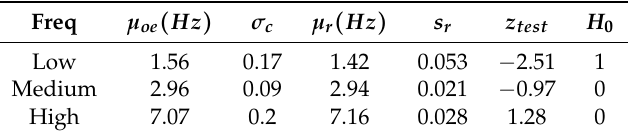
Table 2. Mean frequencies measured by optical encoders and the Rehapiano and their variance, the result of the z-test, and the decision as to whether we can reject the null hypothesis. Freq µ oe ( Hz ) σ c µ r ( Hz ) s r z test H